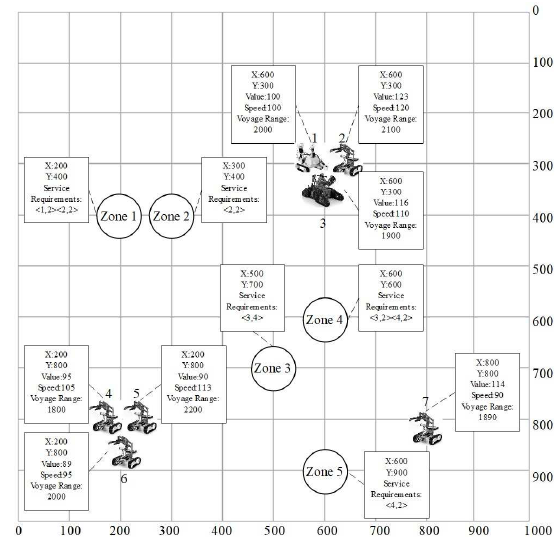
Figure 3. A Simulated Scene for Cooperative Fire Fighting by Swarm Robots. Table 2. Descriptions of 5 Atomic